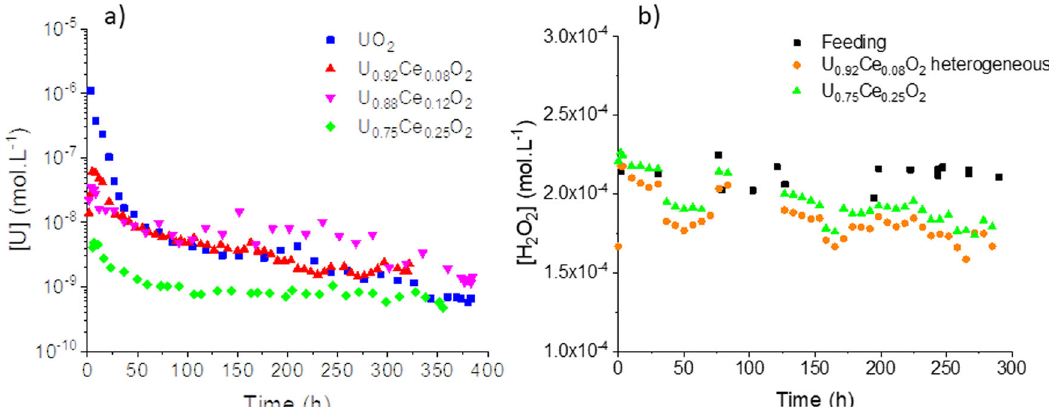
Fig. 8 Evolution of concentrations during dynamic experiments. a Evolution of U elemental concentration during the leaching of homogeneous materials in a solution containing 0.20 mmol.L − 1 of H 2 O 2 , 0.16 mmol.L − 1 of HCO 3- at pH = 7.0 ± 0.2 and 22 °C; b Evolution of the concentration of H 2 O 2 in the inlet and in the outlet of the reactor during the leaching experiments performed on heterogeneous U 0.92 Ce 0.08 O 2 and homogeneous U 0.75 Ce 0.25 O 2 materials. Error bars are twice the standard